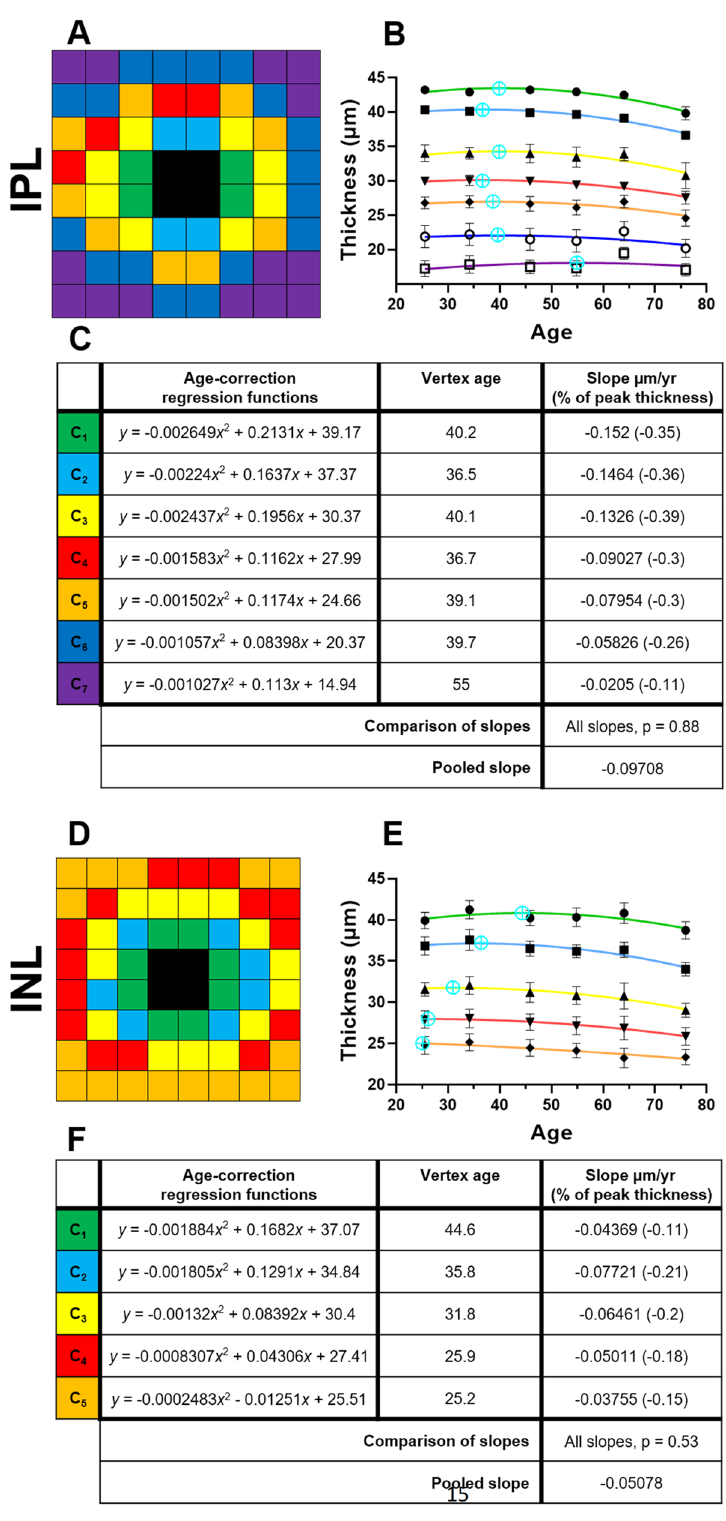
Figure 3. Spatial topography and age-related regression analysis where relevant in the ( A – C ) inner plexiform layer (IPL), ( D – F ) inner nuclear layer (INL), and ( G , H ) outer plexiform layer (OPL), using location-specific cluster analysis. For each layer, the ( A , D , G ) spatial cluster patterns, ( B , E , H ) corresponding plots of cluster thickness versus groups, i.e. age interval cohorts or singular grouping using the whole cohort, and ( C , F ) corresponding age-correction regression functions, vertex ages and slopes as derived after the vertex age are presented. All slopes were significantly different from zero ( p < 0.05). Presentation as in Fig.